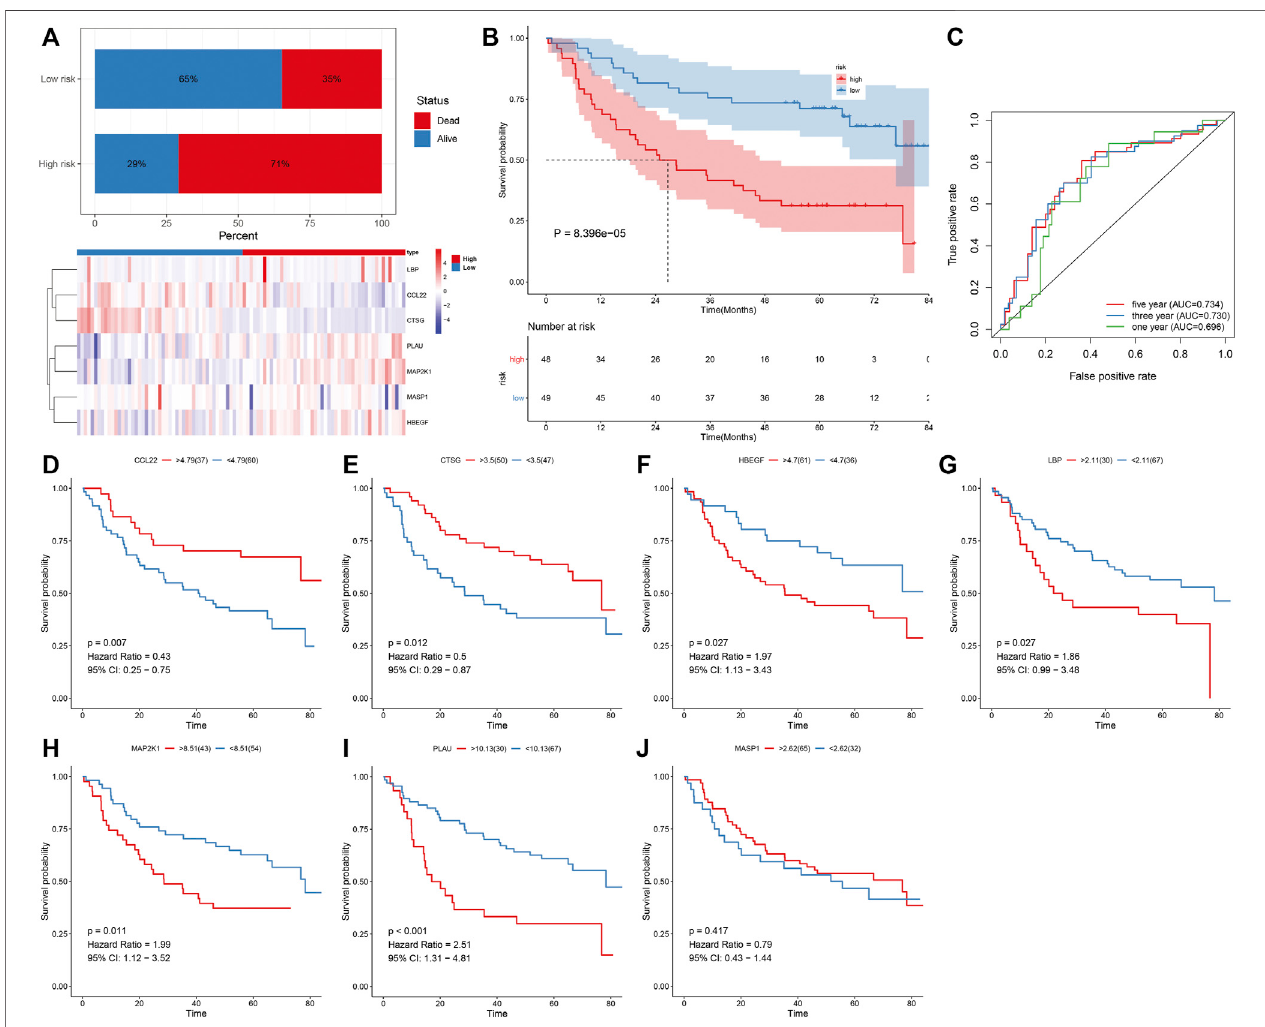
FIGURE 2 | External veri fi cation of predictive performance of IRS in OSCC prognosis in the GSE41613 cohort. (A) Distribution of survival status and expression patternsofcharacteristicIRGsinhigh-and low-riskgroups. (B) TheK – McurvesofOSbetween twogroups. (C) ROCcurves at1-, 3-,and 5-yearOSbasedon theIRS. (D – J) The K – M curves of OS between high and low expression of (D) CCL22, (E) CTSG, (F) HBEGF, (G) LBP, (H) MAP2K1, (I) PLAU, and (J) MASP1 groups.